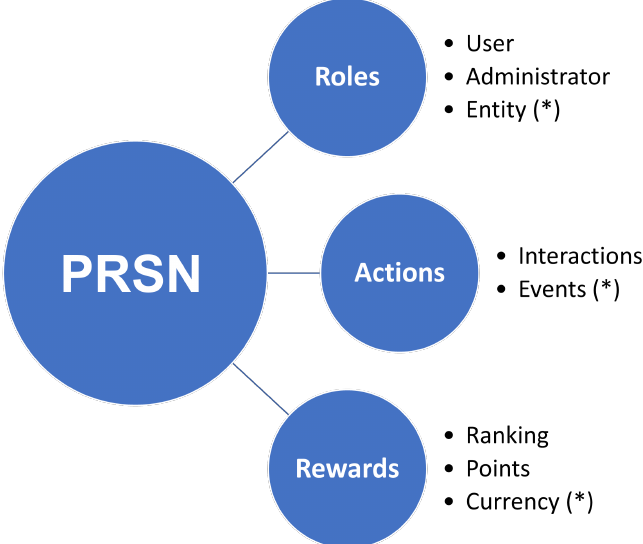
Figure 1. Positive Reinforcement Social Networks visual